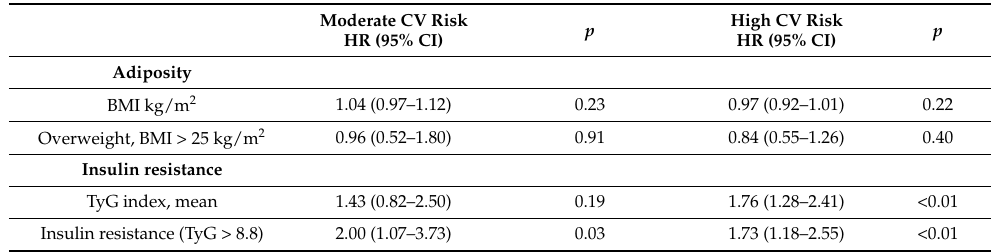
Table 2. Univariate Cox regression analysis of major adverse cardiovascular events of biomarkers among CV risk